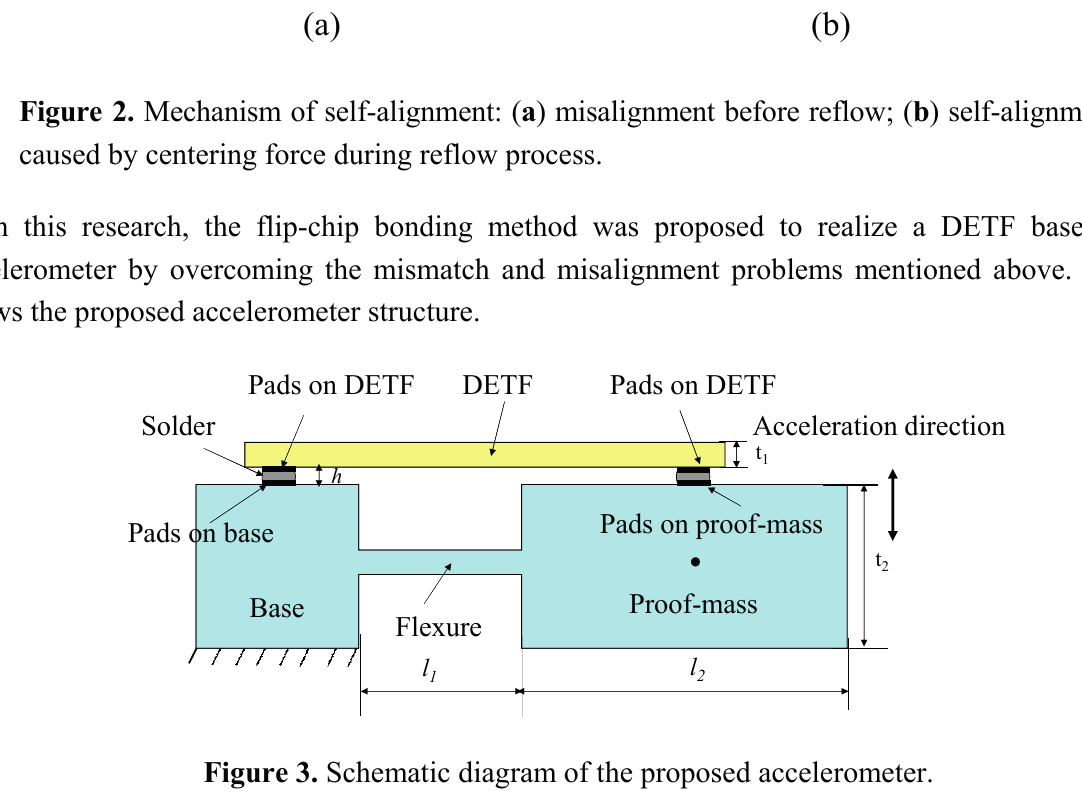
Figure 3. Schematic diagram of the proposed